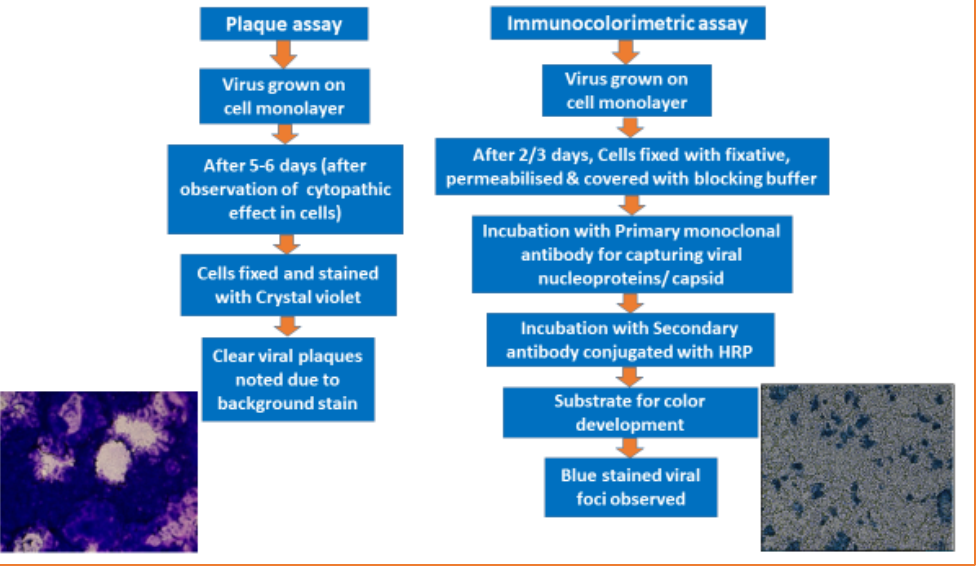
Figure 1. Detection of the mumps virus grown on Vero cell substrates using a plaque assay (after 5 days) and an immunocolorimetric assay (after 2 days).